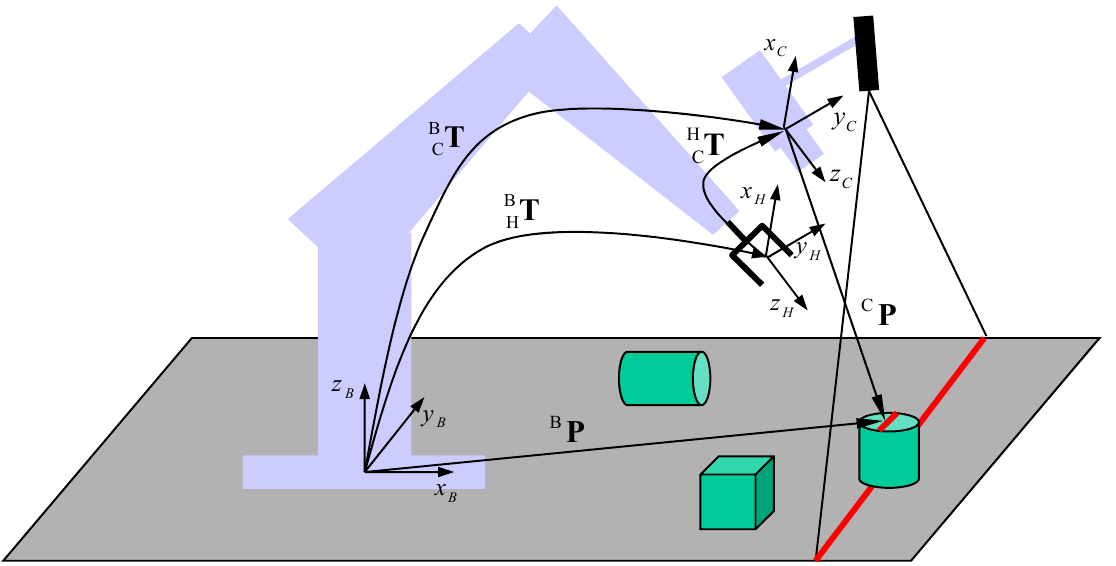
Figure 2. Kinematic model of the hand-mounted laser-vision sensor